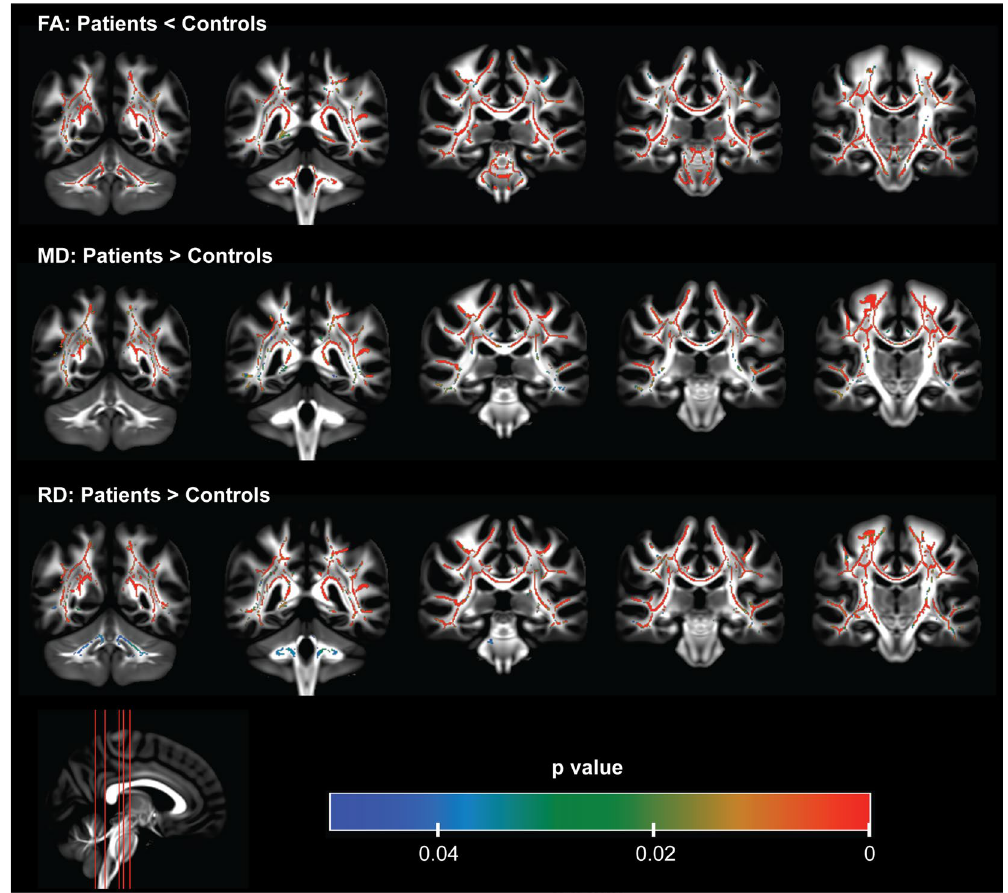
Figure 1. Diffusion tensor analysis showing altered brain white matter microstructure in patients with HD using tract-based spatial statistics. Reduced fractional anisotropy (FA), increased mean diffusivity (MD) and increased radial diffusivity (RD) were observed in the corpus callosum, sagittal stratum, thalamic radiation bundle, superior longitudinal fasciculus, external and internal capsules, corona radiata, and the cingulum. FA was also reduced in the corticospinal tract, and pontine crossing tract. FA and RD were also altered in the cerebellar and cerebral peduncles. The color bar represents significant regions (p < 0.05) of alterations in DTI